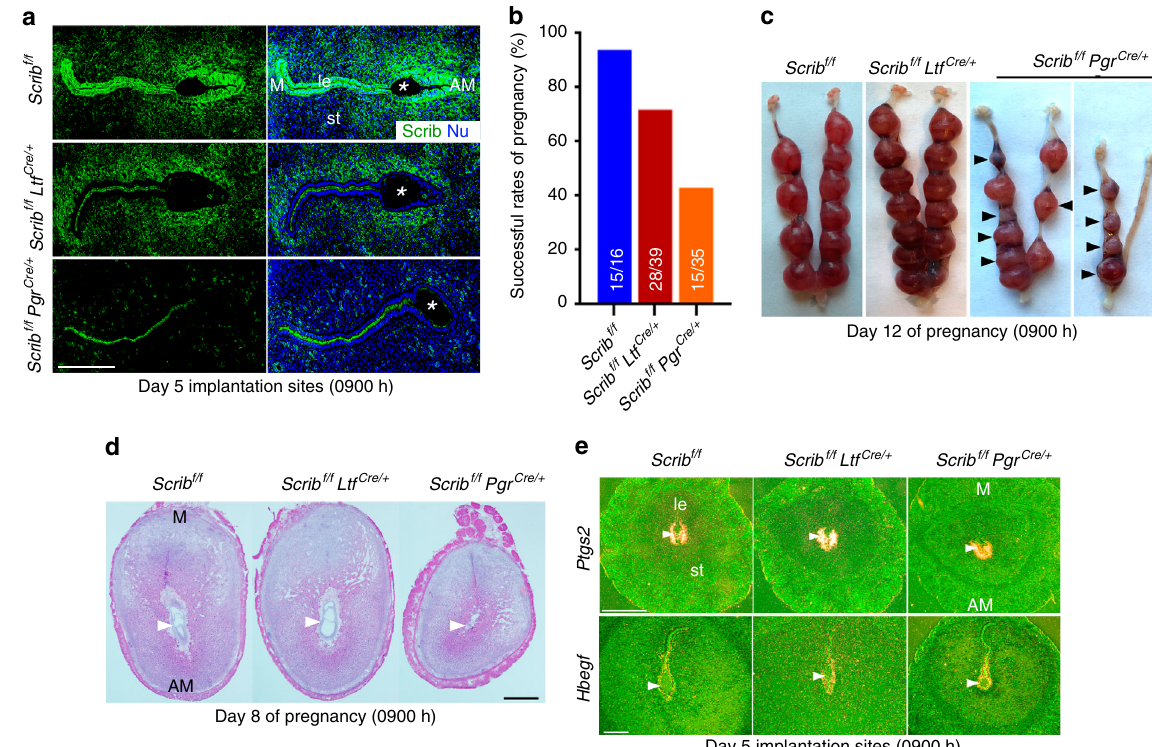
Fig. 1 Disparate pregnancy outcomes in mice deleted of Scrib in the uterus by Pgr-Cre and Ltf-Cre . Uterine ablation of Scrib results in compromised pregnancy outcomes, but exclusively deleted Scrib in uterine epithelium displays normal fertility. a IF localization of Scrib in implantation site on day 5 of pregnancy in each genotype mouse. Asterisks indicate the location of the blastocysts. Scale bar, 200 μ m. b Pregnancy success rate of Scrib f/f , Scrib f/f Ltf cre , and Scrib f/f Pgr cre/ + females. Numbers within the bars indicate the number of females that gave birth to live pups compared with the total number of plug-positive females in each genotype. A number of females were bred more than once contributing to the increased number of mice examined for pregnancy outcomes. c Representative images of day 12 implantation sites in Scrib f/f , Scrib f/f Ltf cre/ + , and Scrib f/f Pgr cre/ + females. Arrowheads indicate embryo resorption sites. d Histology of day 8 implantation sites in each genotype, showing reduced size of the decidual area with degenerating embryos in Scrib f/f Pgr cre/ + females. Arrowheads indicate the location of embryos. Scale bar, 500 μ m. e In situ hybridization of Ptgs2 and Hbegf in Scrib f/f , Scrib f/f Ltf cre/ + , and Scrib f/ f Pgr cre/ + mice in implantation sites on day 5 of pregnancy. Arrowheads indicate the location of blastocysts. Scale bar, 500 µ m (upper panels) and 200 µ m (lower panels). Each image is a representative of at least three independent experiments. M mesometrial pole, AM antimesometrial pole, le luminal epithelium, st